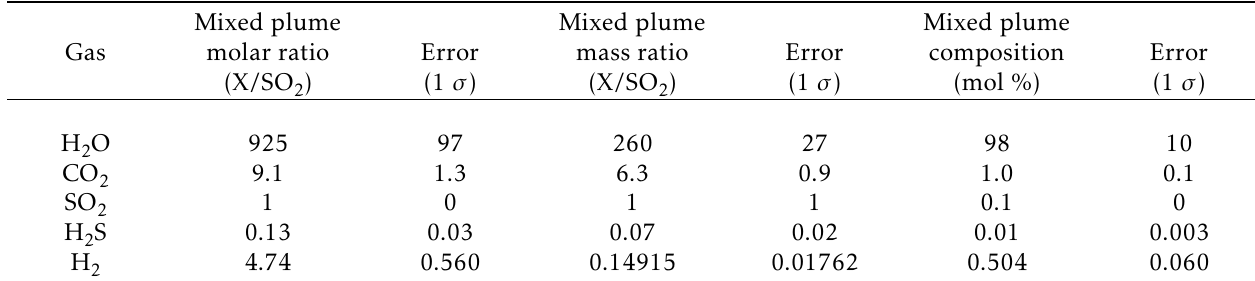
Table 2 – X/SO molar and mass ratios measured by Multi-GAS and gas composition of the plume at Chillán 2 volcano. Error are expressed as the standard error of the regression analysis and subsequent error propagation.